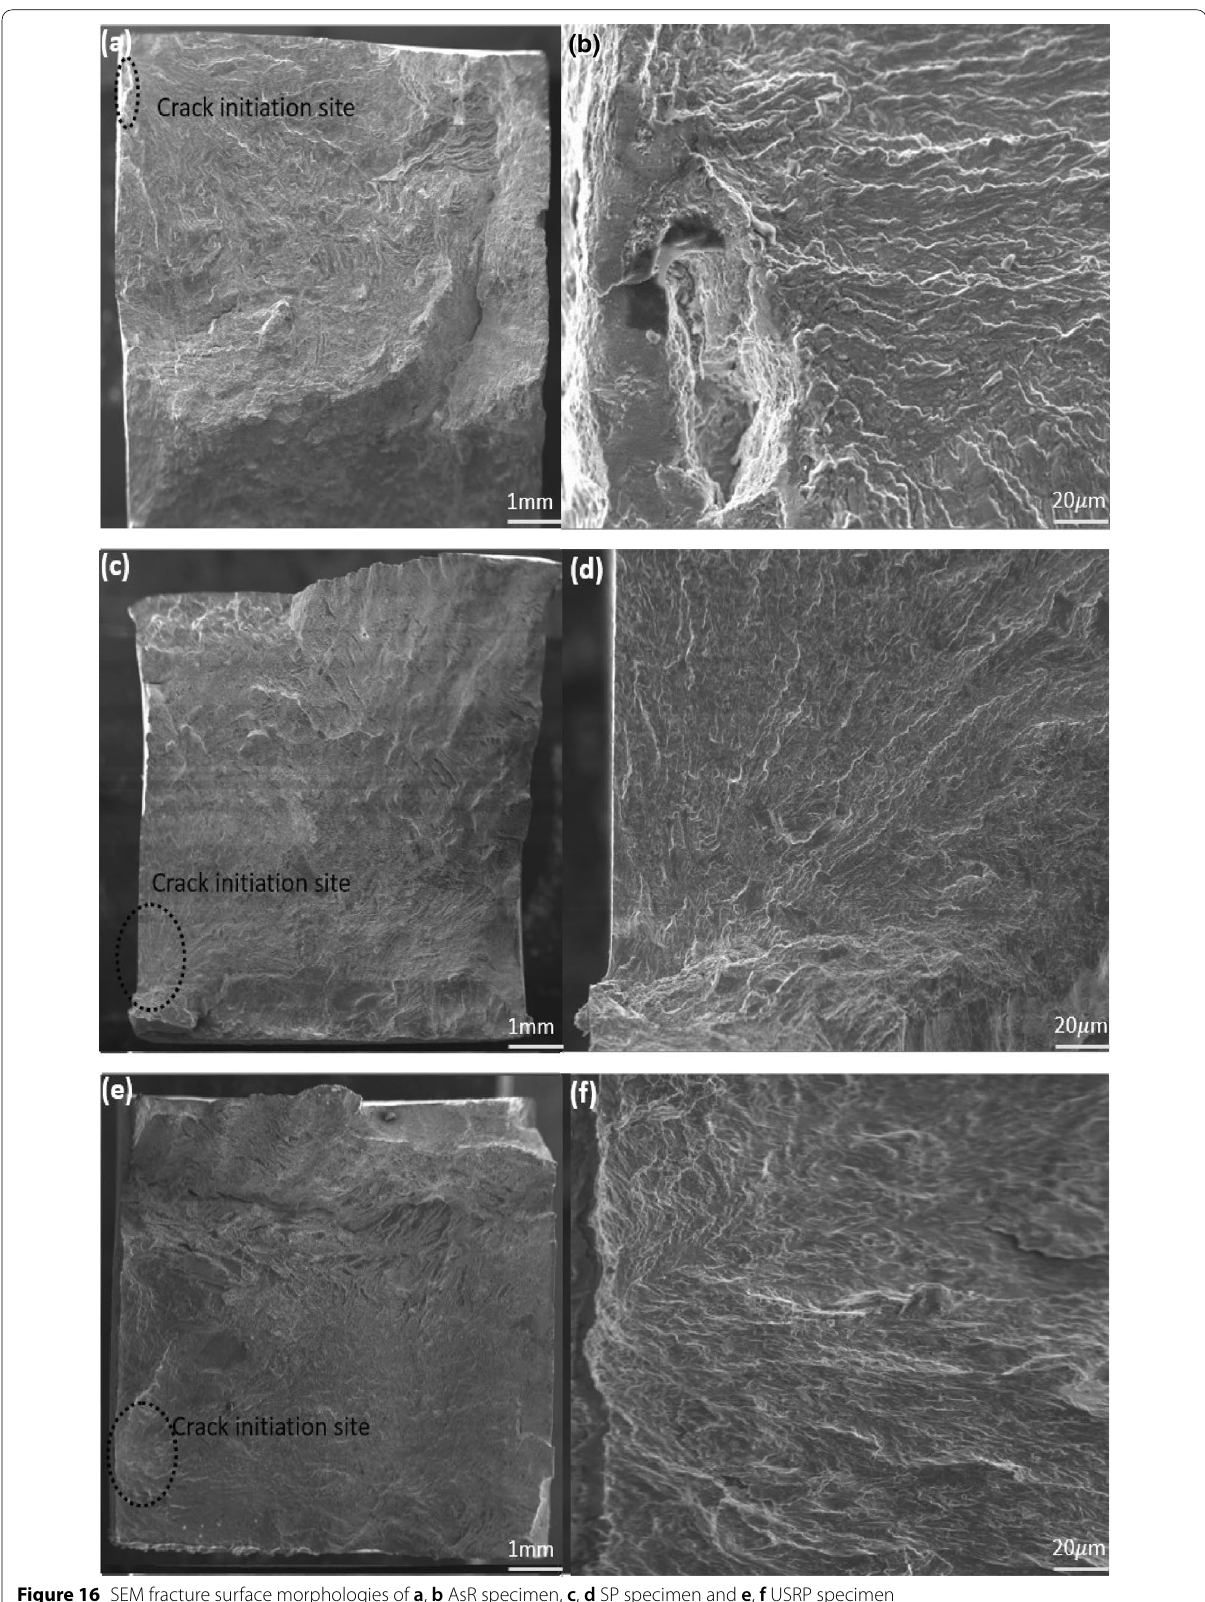
Figure 16 SEM fracture surface morphologies of a , b AsR specimen, c , d SP specimen and e , f USRP